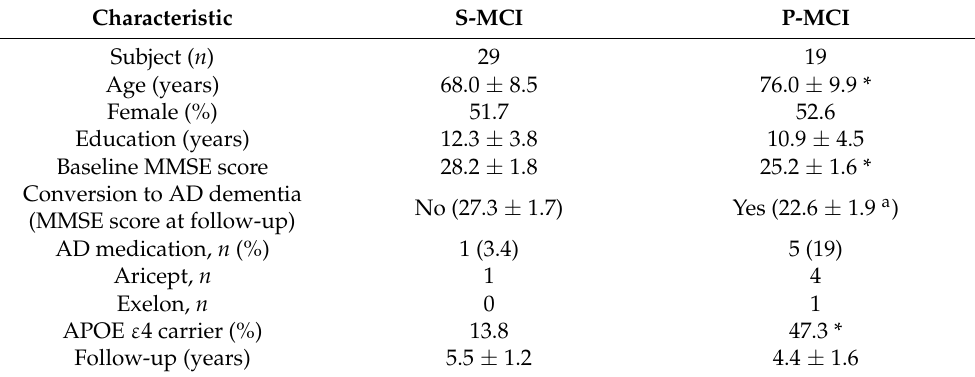
Table 1. Characteristics of the 49 individuals defined as P-MCI patients and S-MCI patients.